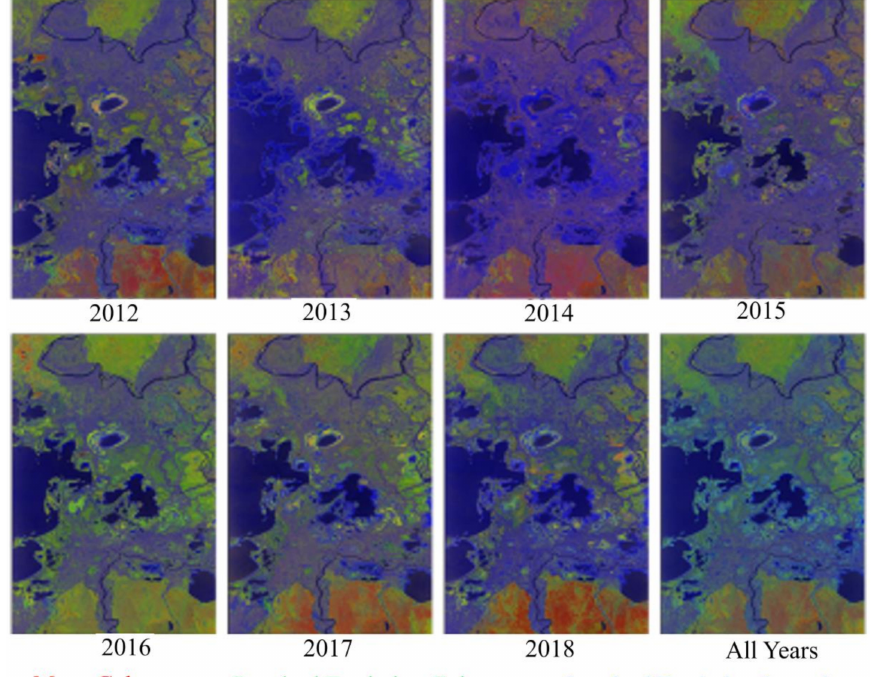
Figure 2. Multi-polarization data from Radarsat-2 illustrating mixtures of coherence statistics. These statistics are associated with mean coherence (mostly red upland vegetation), standard deviation coherence (mixture of mostly green and some red with variation depending on vegetation structure) and blue to blue-green related to open water, aquatic and flooded vegetation within the Peace Athabasca Delta, Alberta